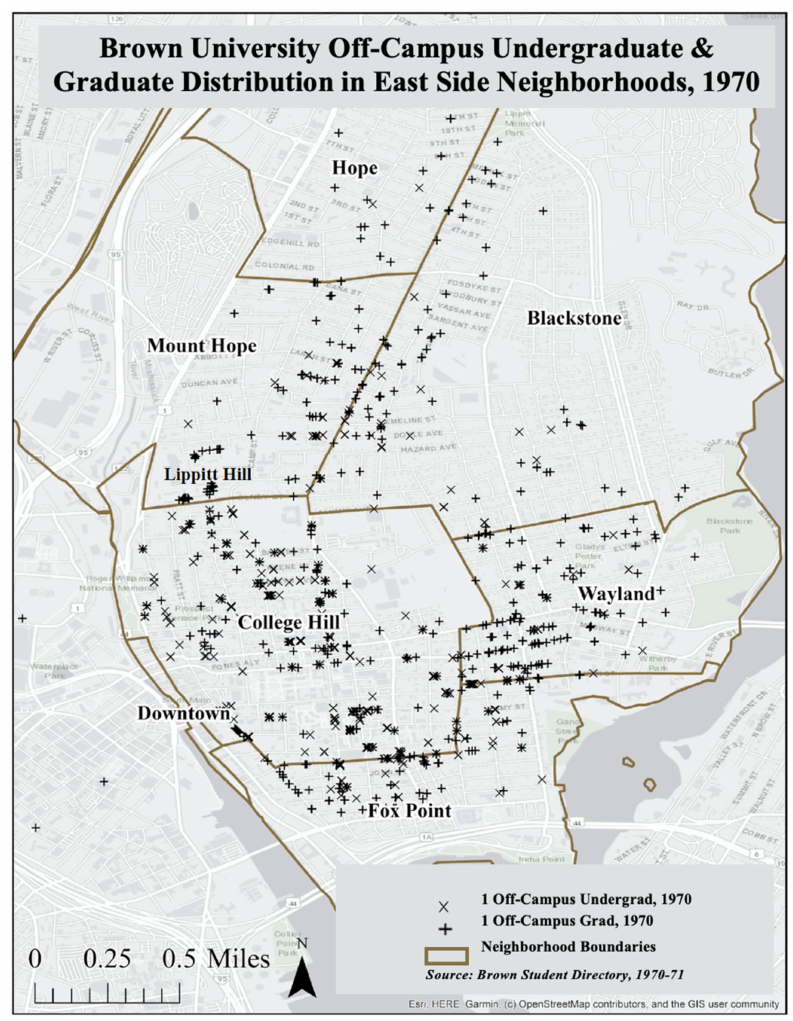
Figure 5. Brown University o ff -campus undergraduate and graduate distribution in East Side neighborhoods, 1970. In 1970, 591 undergraduates lived at Providence o ff -campus addresses. This constituted 14% of the undergraduate population. The percent o ff -campus is inclusive of all undergraduates with a Providence address (including some in neighborhoods beyond the East Side) and calculated using historical enrollment data; 652 graduate students lived at Providence o ff -campus